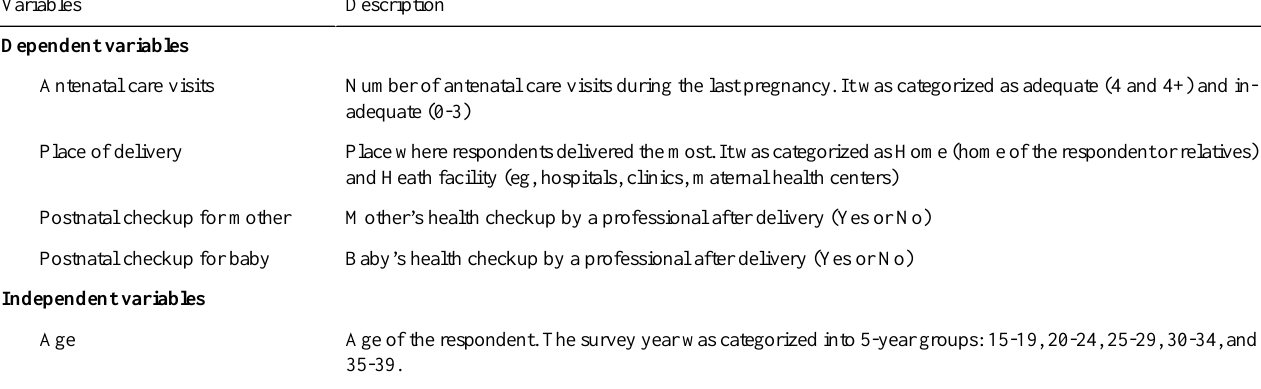
Table 1. Description of dependent and independent variables.